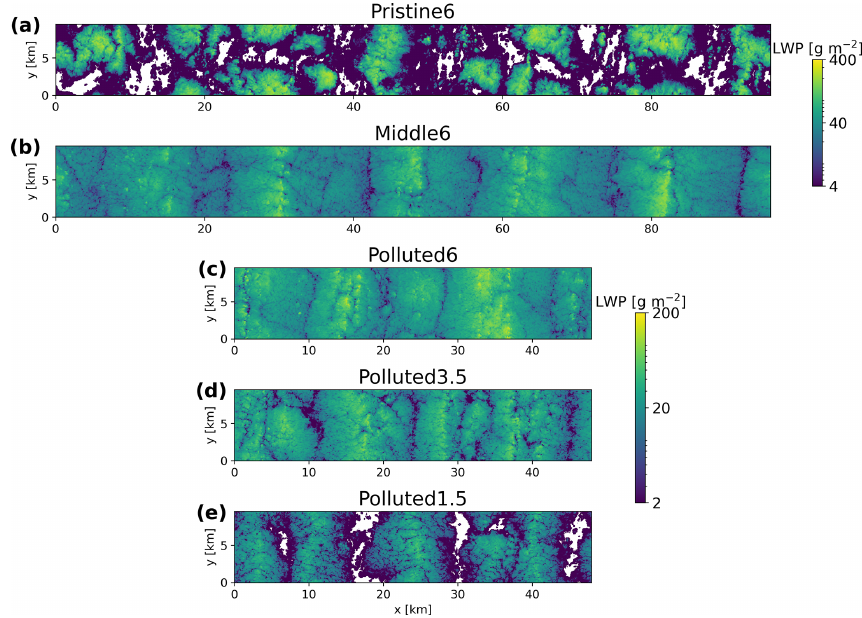
Figure 1. Horizontal fields of the LWP at local noon (12:08LT) on Day 1 in the Ctrl run for the Pristine6, Middle6, Polluted6, Polluted3.5, and Polluted1.5 cases.